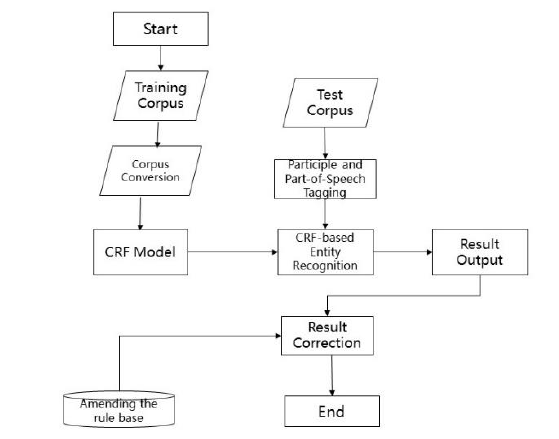
Figure 6 . Flow chart of named entity recognition based on CRF and rule space